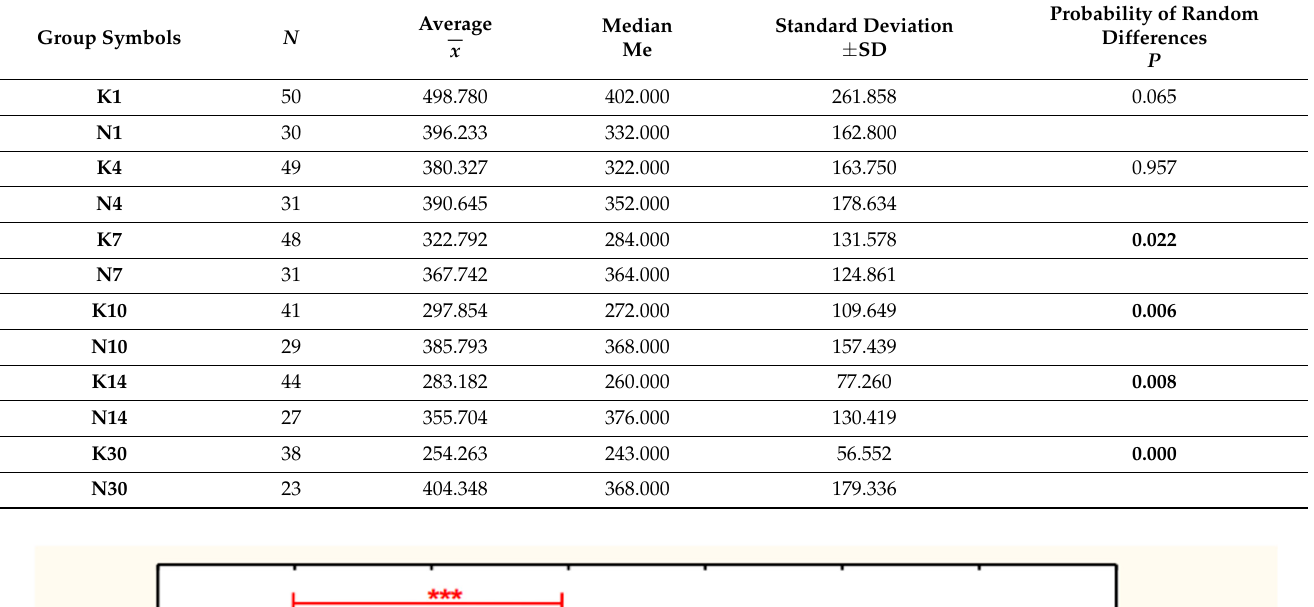
Table 1. The concentration of serum HEX activity (nKat/L) in alcohol-dependent patients treated with neoglandin (N1–N30) and the control group not treated with neoglandin (K1–K30). Blood samples were collected on days 1, 4, 7, 10, 14 and 30 of hospitalization.